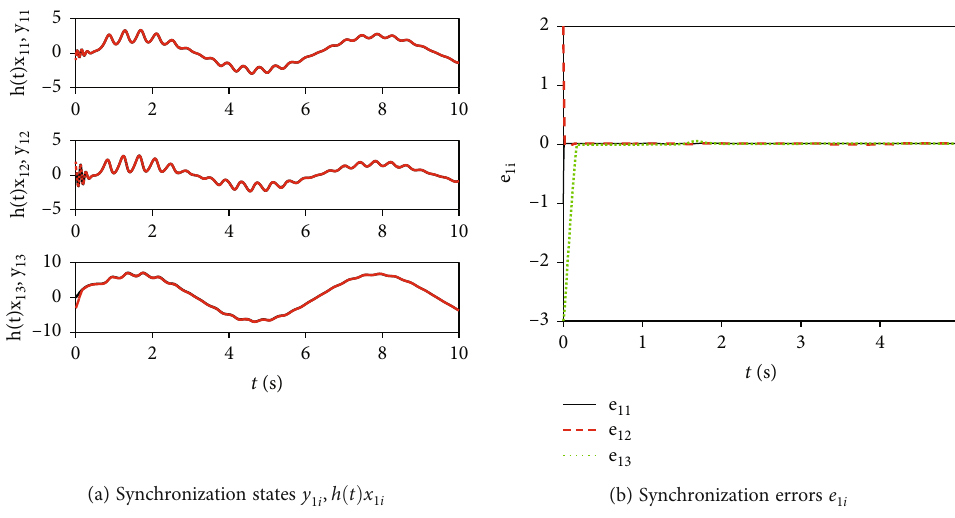
Figure 3: The time evolution of synchronization between y